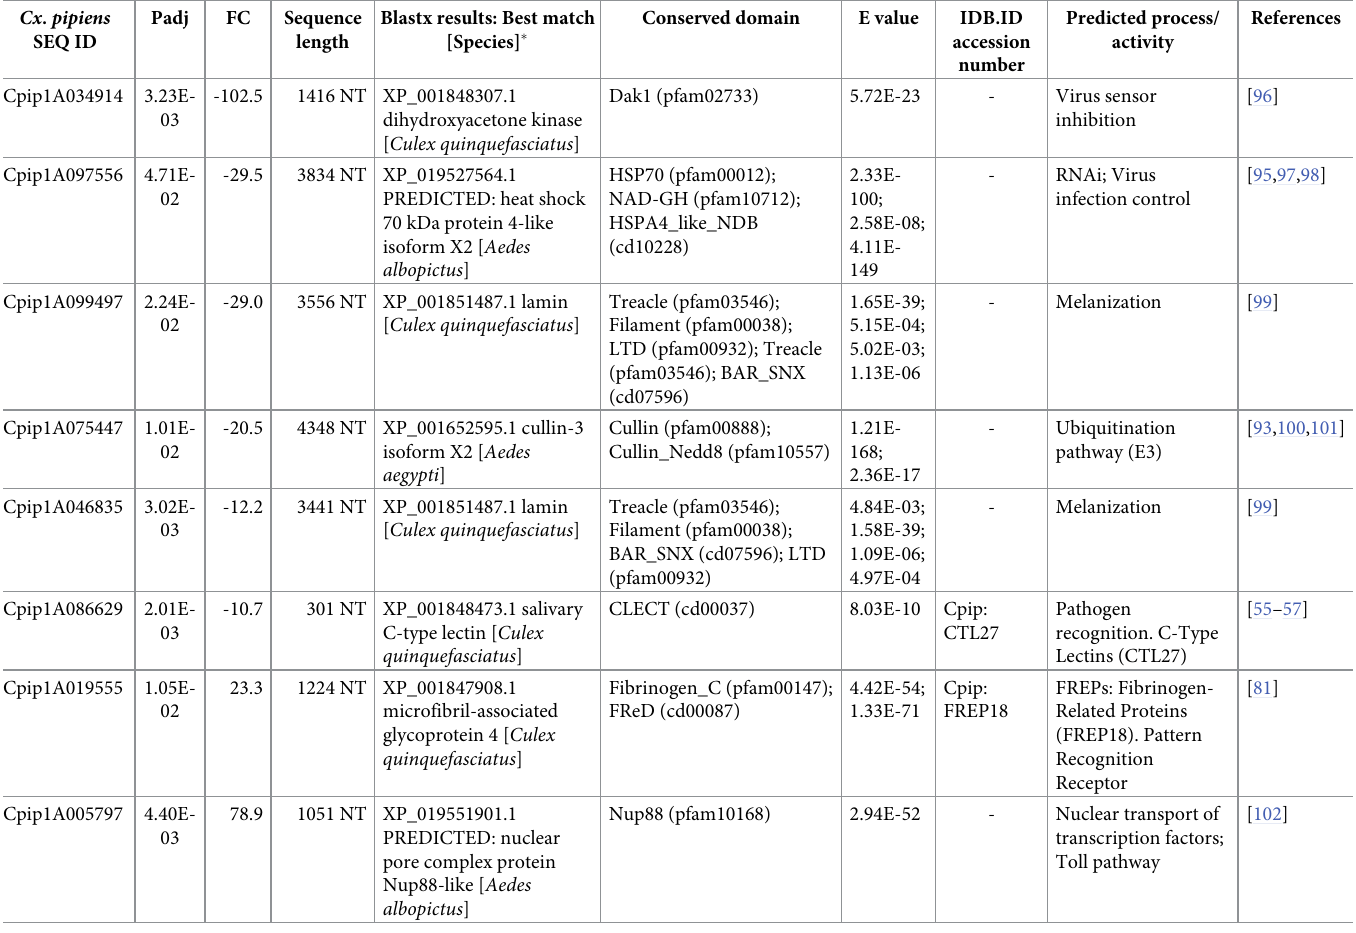
Table 4. DEG related to the immune infection-defense response at 14